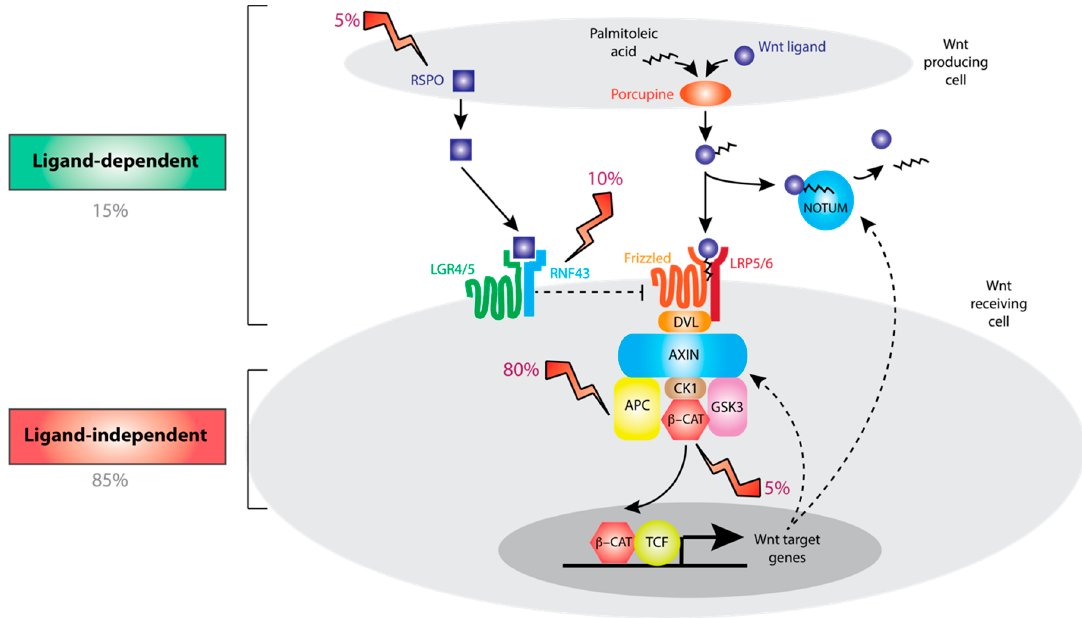
Figure 1. Overview of Wnt signaling pathway. Wnt ligands secreted from stromal cells are activated by porcupine-mediated post-translational modification and bind to Frizzled (FZD) receptors on Wnt receiving cells. This functions to inhibit a destruction complex containing axin-like protein (AXIN)1/2 and adenomatous polyposis coli (APC) thus disinhibiting β -catenin (CTNNB1), the master transcriptional regulator of Wnt singaling. Frizzled receptors are degraded due to the action of ring finger protein 43 (RNF43), which is in turn inhibited by binding of R-spondin (RSPO) ligands to leucine-rich repeat-containing G protein-coupled (LGR) family receptors, thus augmenting Wnt signaling tone. Wnt pathway activation is regulated at multiple levels by negative feedback loops, including those mediated by AXIN2 and notum palmitoleoyl-protein carboxylesterase (NOTUM). Recurrent mutations in CTNNB1 and APC result in ligand-independent pathway activation while mutations in RSPO and RNF43 depend upon binding of Wnt ligands to Frizzled receptors. GSK: glycogen synthase kinase; LRP: lipoprotein receptor-related protein.